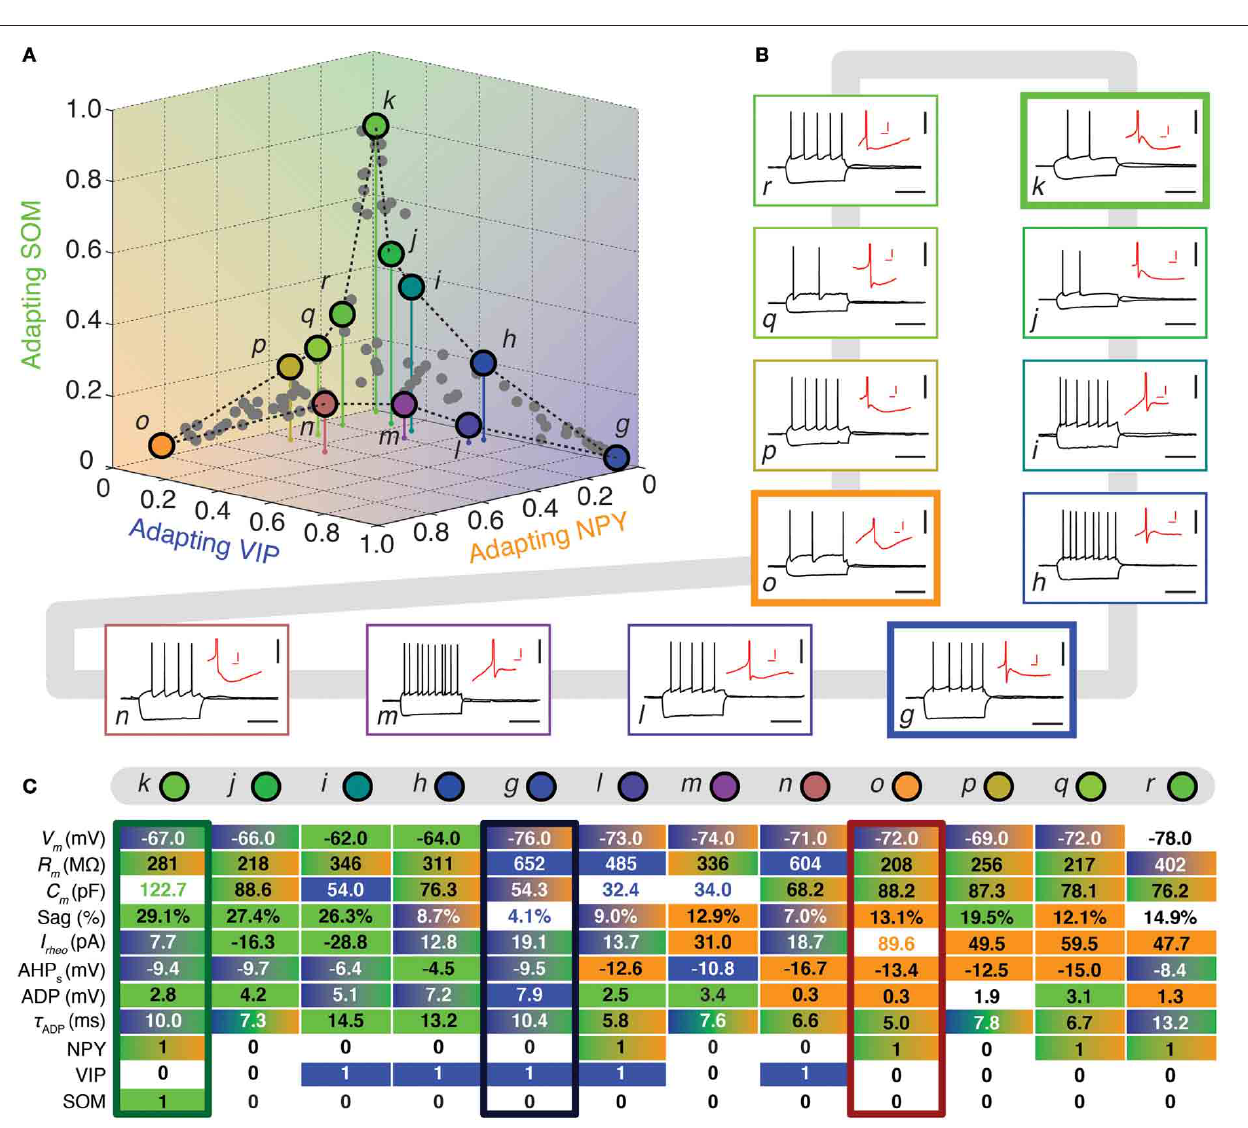
phase of the first spike (red traces, scale bars 5mV, 20ms). (C) Table summarizing 8 electrophysiological and 3 molecular discriminative properties of transitions cells between the Adapting VIP, the Adapting SOM, and the Adapting NPY archetypes. Blue, green, and orange backgrounds indicate distinctive values for the Adapting VIP, the Adapting SOM, or the Adapting NPY archetype, respectively. Gradient backgrounds indicate values falling in a range typical for multiple. Bold colored entries indicate extreme values for an archetypal trend. Thick contours highlight columns corresponding to archetypal cells. Atypical cells display a heterogeneous mixture of property values which are not compatible with a single archetype or which fall in transition